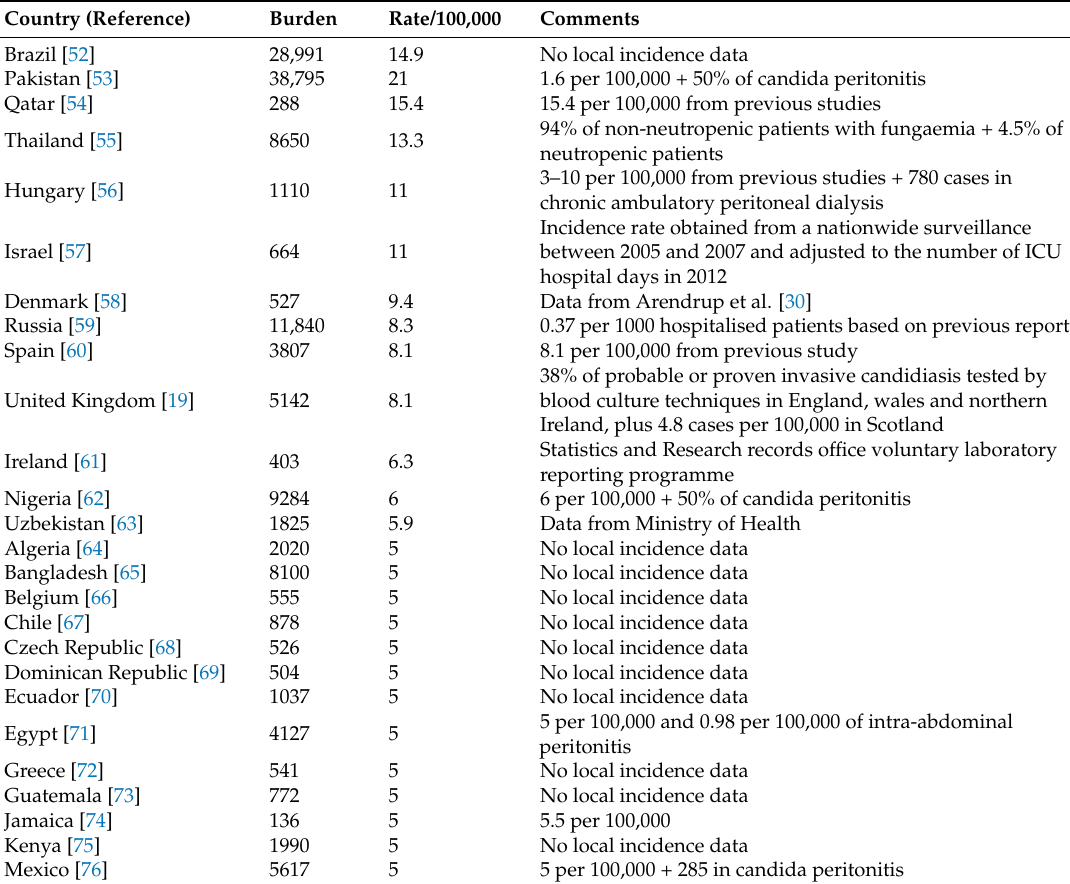
Table 2. Country estimated burden of